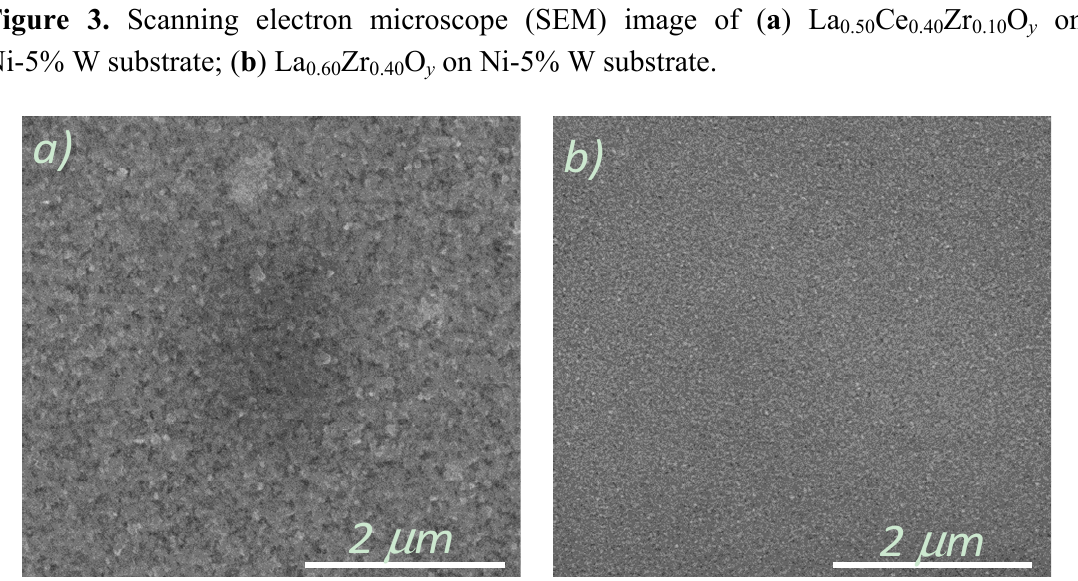
Figure 3. Scanning electron microscope (SEM) image of ( a ) La